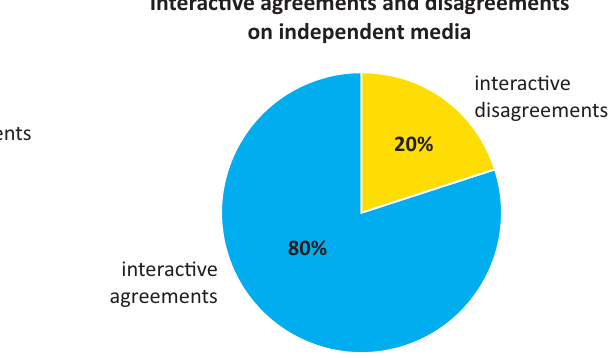
agreements was linked to the claim making and valida- tion process which allows focusing only on the most re- cent acts of agreement-disagreement related validations.